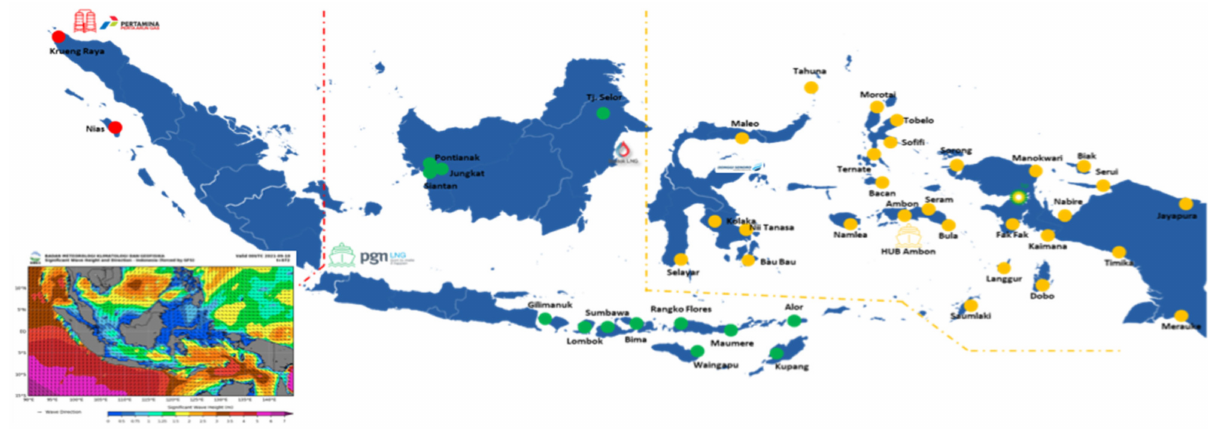
Figure 2. LNG Refinery Location, PLTG/PLTMG Location, and Wave Height